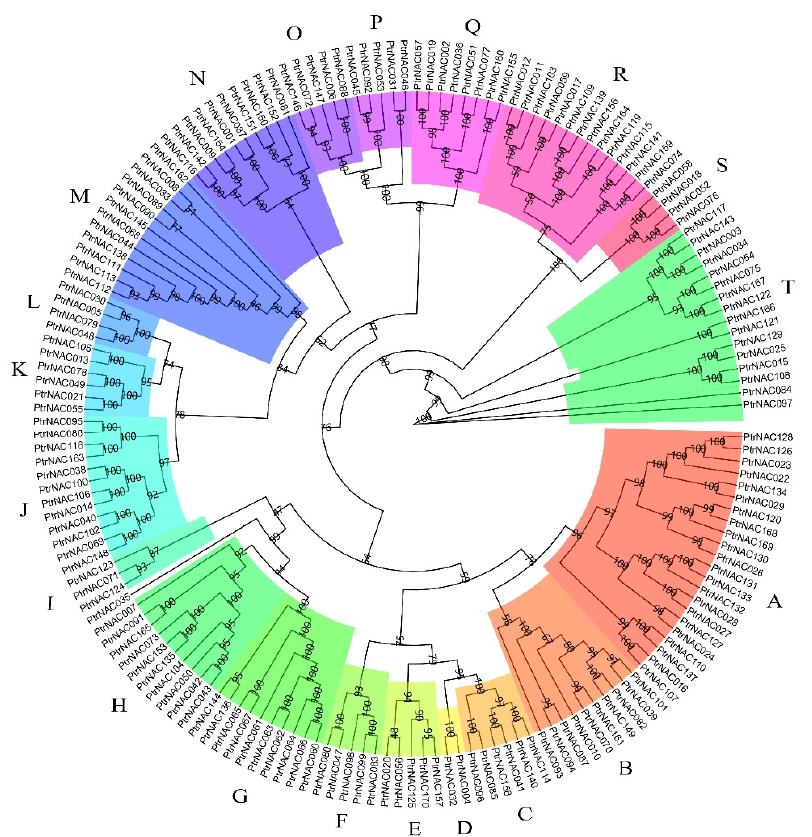
Figure 3. Evolutionary analysis of poplar NAC proteins. The ML (maximum likelihood) phylogenetic tree was reconstructed using IQ-TREE (v1.6.12) with ‘JTT + F+R7 ′ model and 1000 bootstrap replicates. The bootstrapping values were shown at the nodes in the ML tree. The twenty NAC subfamilies were marked in different colors, and their names were signed with the A–T letters.